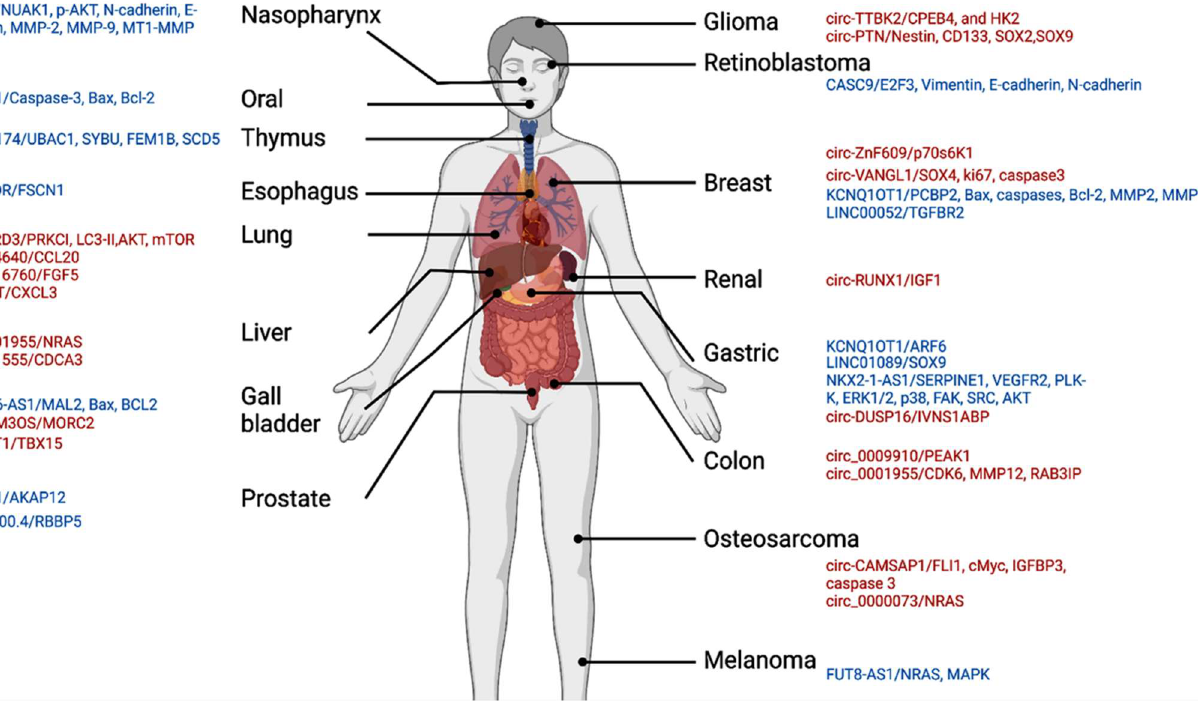
Table 4. Association between miRNA and clinical parameters in cancer patients.